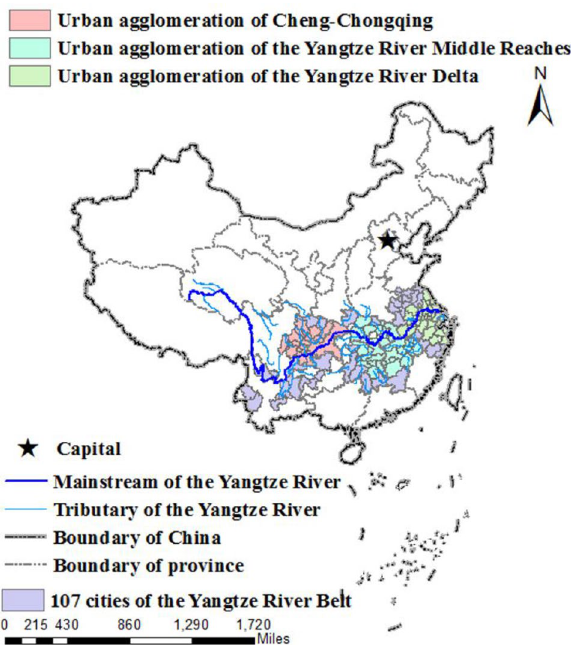
Figure 2. The geographic location of the YREB in